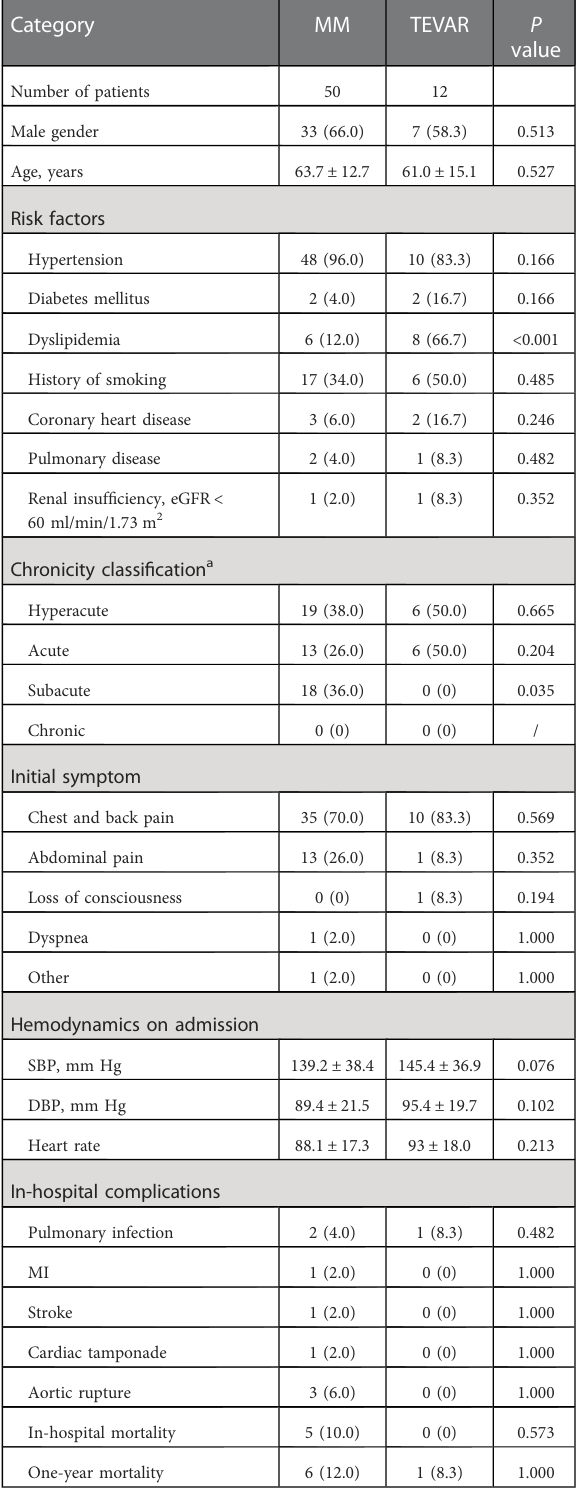
TABLE 3 Clinical characteristics of TEVAR group and MM group.